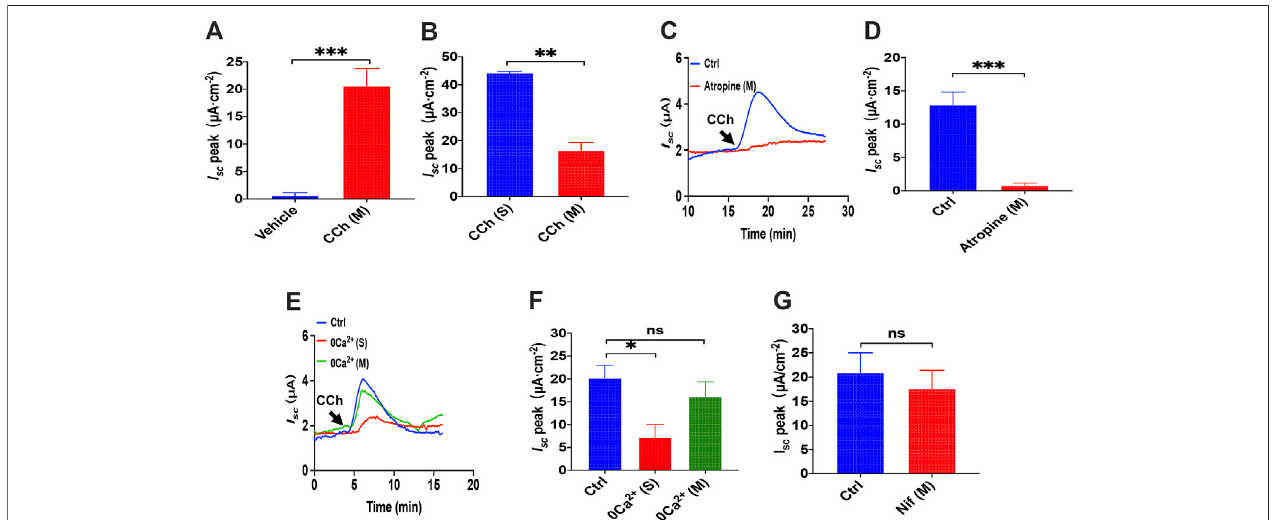
FIGURE 9 | luminal CCh induced Ca 2+ -dependent duodenal I sc through serosal Ca 2+ entry. (A) Summary data of vehicle (H 2 O) or CCh (100 μ M) -stimulated I sc peak after mucosal application ( n (cid:2) 6). (B) Comparison between CCh-evoked I sc peak after mucosal and serosal application. (C,D) luminal CCh-induced duodenal I sc after atropine (10 μ M, n (cid:2) 6) added to the mucosal side. Ctrl represents the control without atropine treatment. (E,F) luminal CCh-evoked I sc after extracellular Ca 2+ omitted from the serosal or mucosal side ( n (cid:2) 6). Ctrl represents as the control in which normal extracellular Ca 2+ was on both sides. (G) luminal CCh-evoked duodenal I sc aftermucosaladditionofNifedipine(Nif,10 μ M, n (cid:2) 6).CtrlrepresentsthecontrolwithoutNiftreatment.Resultsarepresentedasmean ± SE.* p < 0.05,** p < 0.01, *** p < 0.001 vs. corresponding control by Student ’ s unpaired, two-tailed t-test.